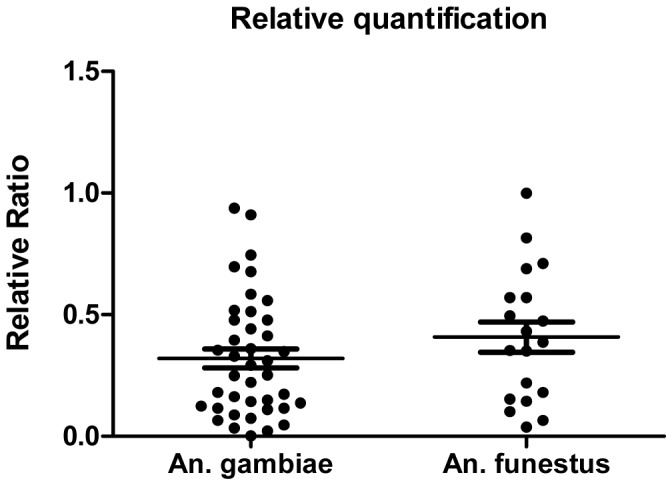
Absolute and relative quantification of Plasmodium DNA in mosquitoes.This figure shows a not significant difference was observed in the P. falciparum densities between the two Anopheles species (P-value = 0, 2197).